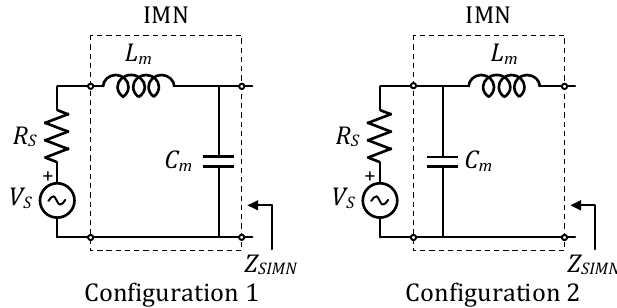
Figure 5. L-section matching network configuration.